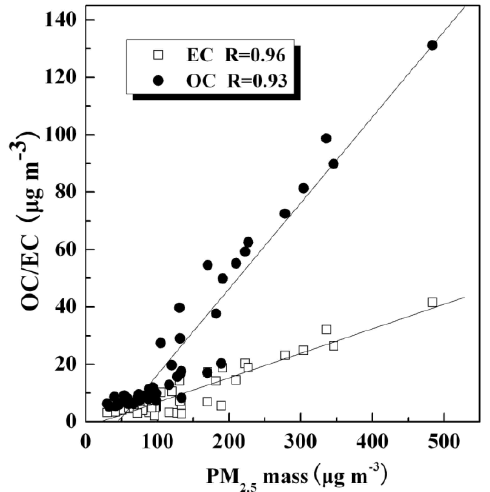
Figure 5. Relationships between OC/EC and PM 2.5 mass